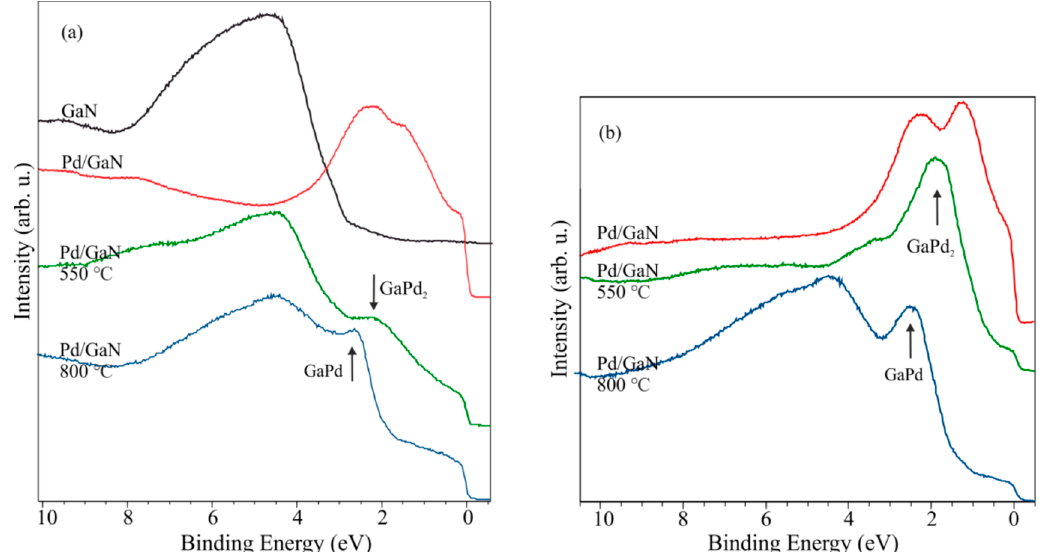
Figure 28. ( a ) UPS spectra for bare and Pd-covered p-GaN(0001), before and after annealing at 550 and 800 ◦ C. ( b ) Spectra and 800 °C. ( b ) Spectra for another cycle of Pd deposition and annealing. Reprinted with permis ‐ for another cycle of Pd deposition and annealing. Reprinted with permission from [34]. Copyright 2015 Springer